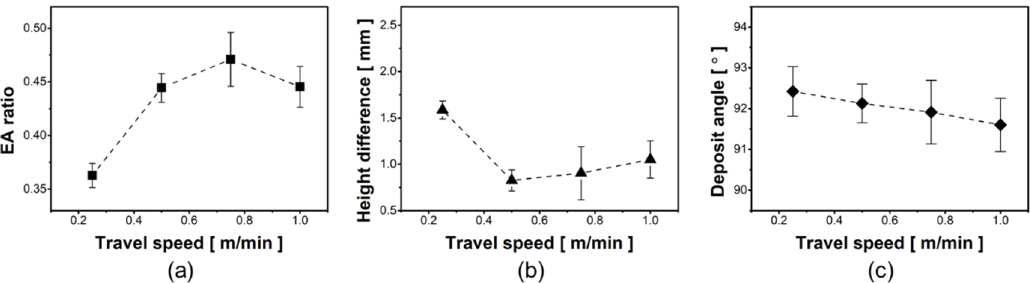
Figure 5. Experimental results depending on travel speed: ( a ) the EA ratio, ( b ) height difference, and ( c ) deposit angle.